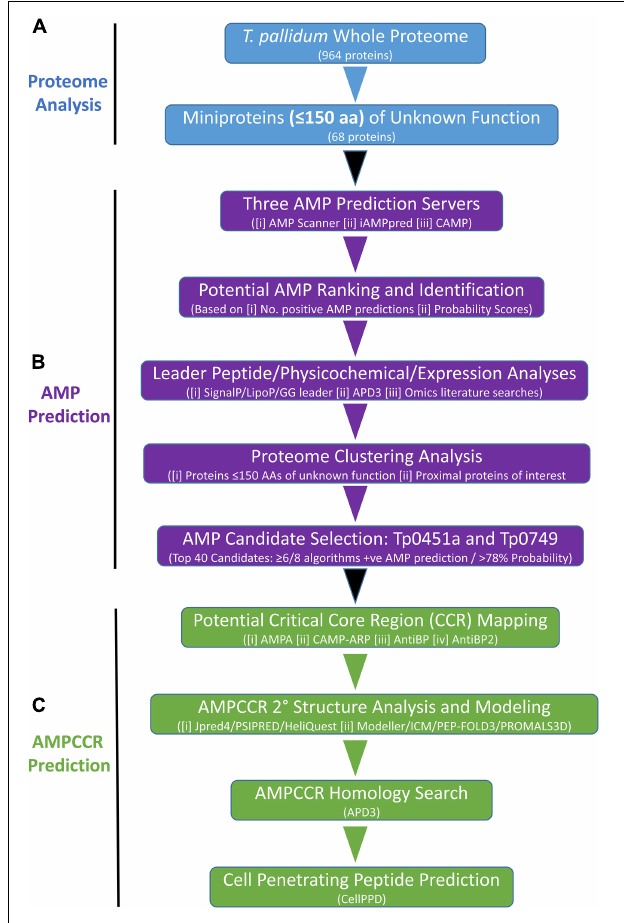
FIGURE 1 | Bioinformatics pipeline for the identification of potential AMPs and AMPCCRs in the proteome of T. pallidum . (A) Proteome Analysis: The whole proteome (from NCBI genome database, July 2021 annotation) of T. pallidum was searched for proteins with no assigned function and 150 amino acids or less. (B) AMP Prediction: Complete amino acid sequences of 68 T. pallidum proteins ( ≤ 150 amino acids) of unknown function were submitted to three AMP prediction servers which allowed for ranking from most likely AMP to least likely AMP. Additional leader peptide, physicochemical, expression, and proteome clustering analyses facilitated the identification of two potential AMPs (Tp0451a and Tp0749) for further analyses. (C) AMPCCR prediction: A combination of critical core region (CCR) mapping, structural, homology, and cell penetrating peptide analyses were then performed to further confirm the initial AMP predictions generated by the three prediction servers and to identify putative antimicrobial peptide critical core regions (AMPCCRs) within the identified predicted AMPs, Tp0451a and